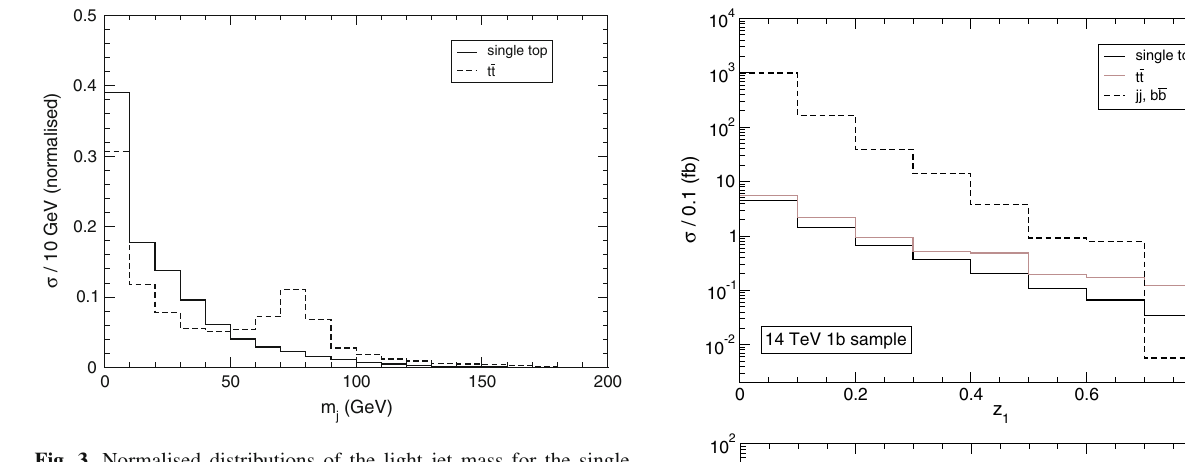
sections as a function of the lepton momentum fraction z 1 are presented in Fig.